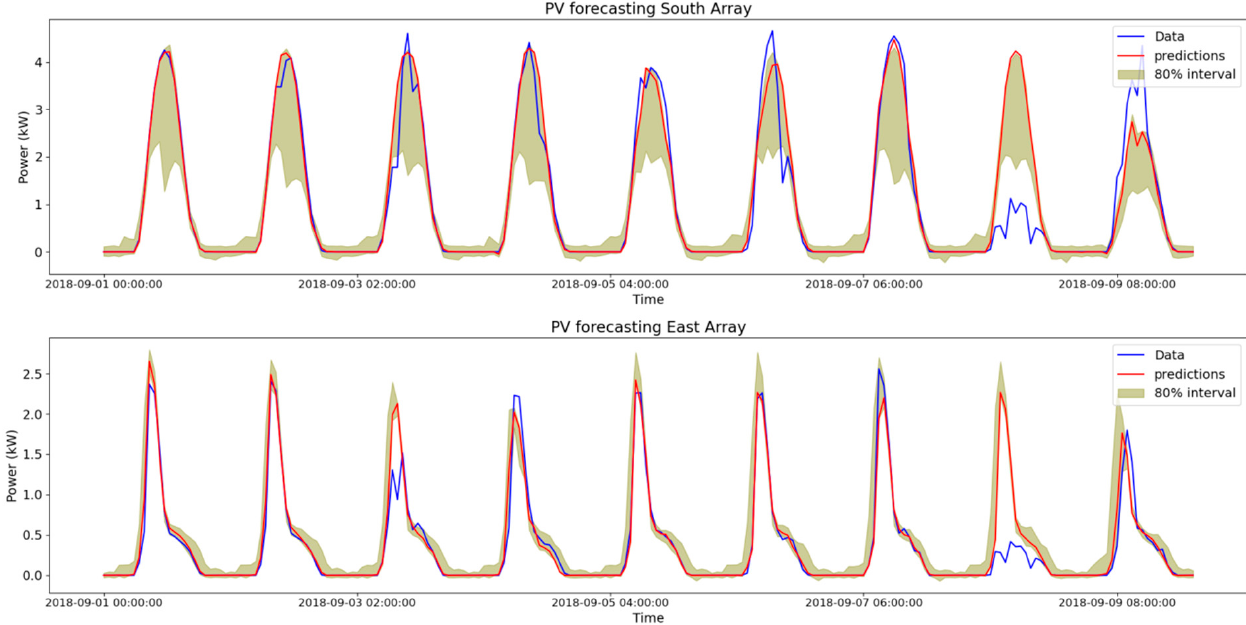
Figure 8. Probabilistic forecasting of the BIPV power for south and east arrays.